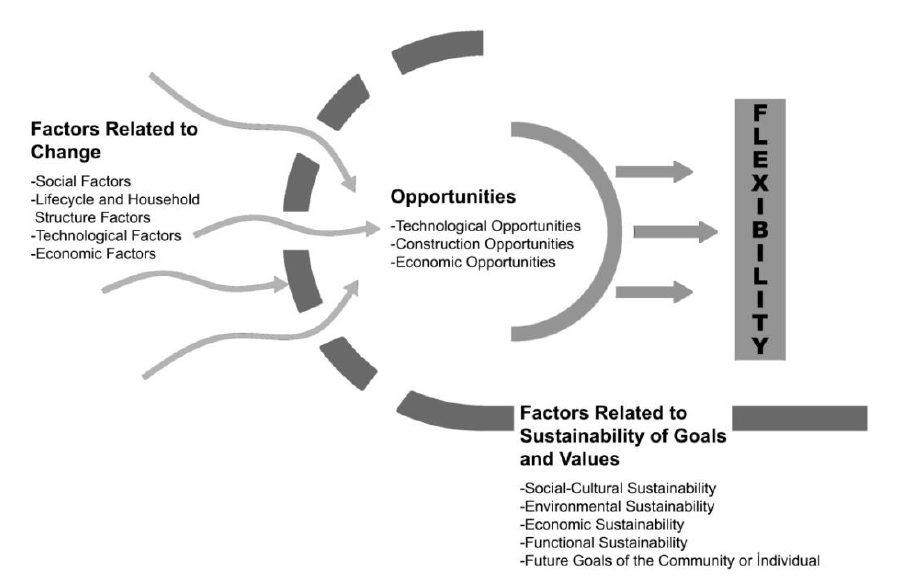
Figure 7 The conceptual model on the relationship of the factors involved in housing flexibility (developed by